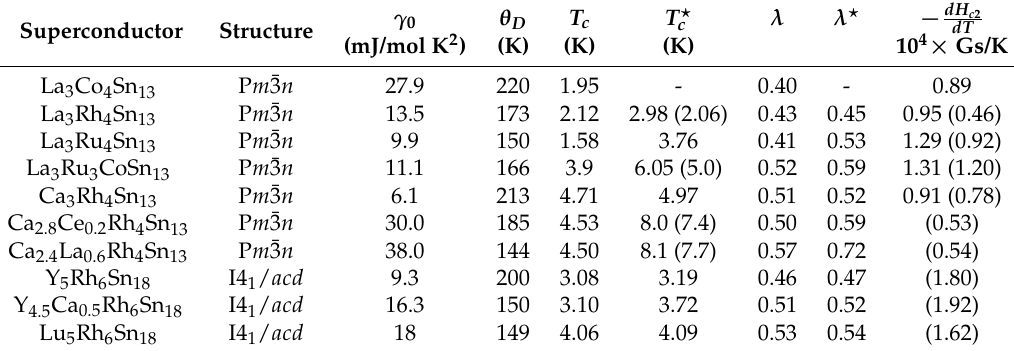
Table 1. The parameters characterizing the superconducting samples. The electronic specific heat ( n ) ∼ 2 N ( (cid:101) ) is obtained in the normal state ( T > T (cid:63) γ F 0